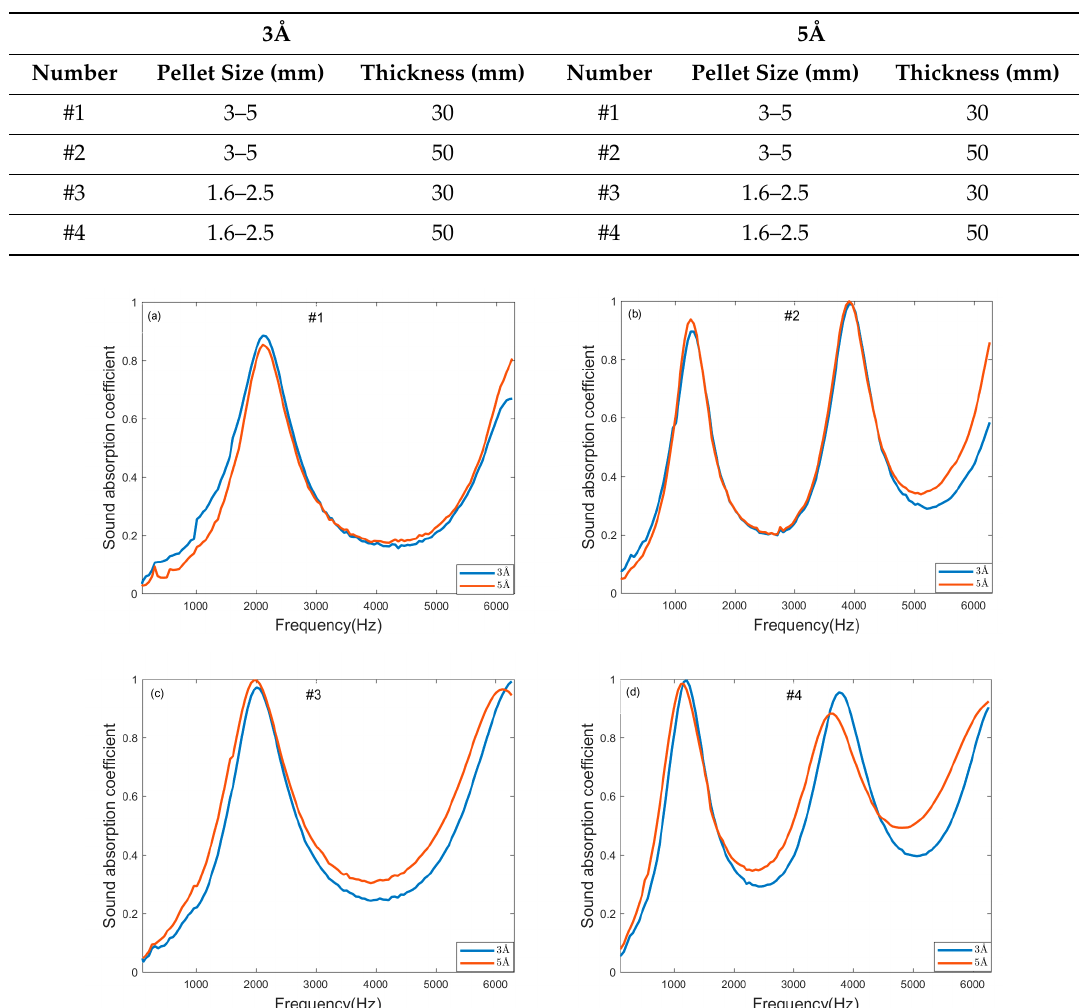
Table 1. Characteristics of the molecular sieve pellet samples with different pore sizes.